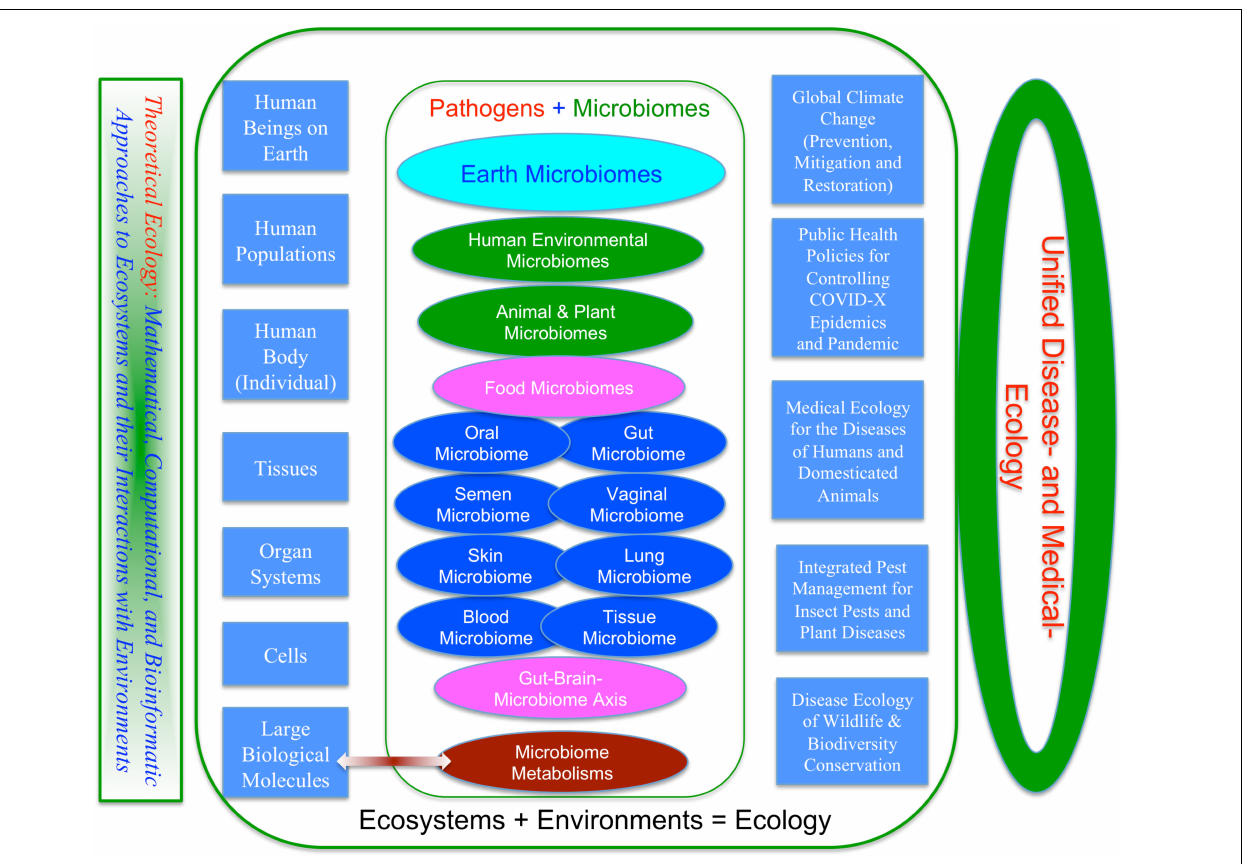
FIGURE 5 | Toward a unified disease and medical